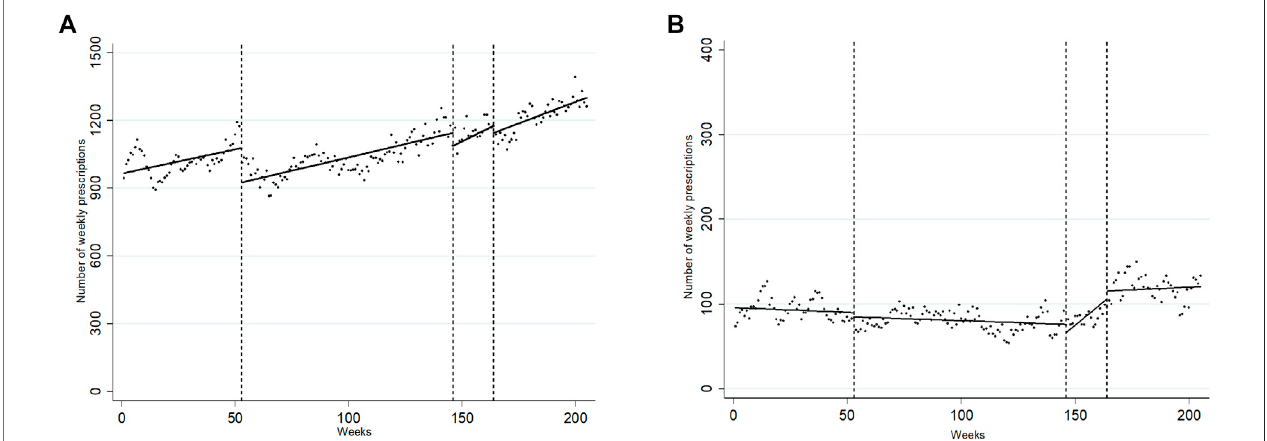
FIGURE 3 | Segmented linear regression trends of weekly series of IRF prescription for BCP in patients with chronic cancer pain treatment (A) and in patients withoutchroniccancerpaintreatment (B) ,2015 – 2018.Dots:observedweeklyvolumeofprescription; Line:predictedweeklyvolume ofprescription.Week 0: fi rstweek of January 2015; Week 53: fi rst medication review; Week 146: second medication review: Week 164: issue of safety warning. Week 205: last week of November 2018. Created by the